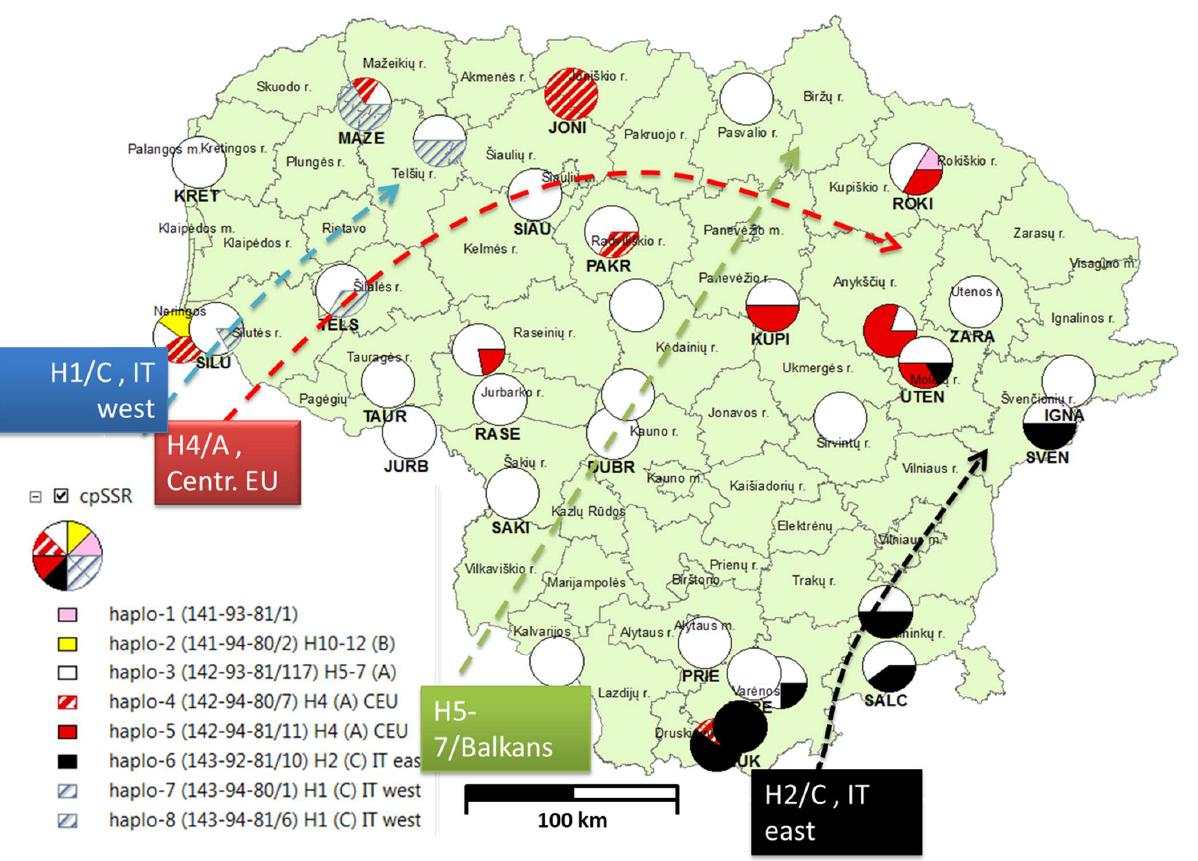
Figure 2. Geographical distribution of Q. robur chloroplast DNA haplotypes in Lithuania. The haplotypes are explained in the legend, where the haplotype id, allele scores (both as in our study), number of trees after the slash, the haplotypes as in [14], and the post-glacial migration lineages as in [19] are given. The dashed arrows indicate hypothetical migration routes of the postglacial migration linages identified as in [19] assuming natural migration being the main driver of the present distribution of the haplotypes. Table 3. Synchronizing the alleles for the two cpSSR loci from our and the two other studies on Q. robur with the aim to assign the cpSSR haplotypes to the postglacial migration lineages by [19]. Q. robur. The table includes all alleles found at the loci in all three studies.